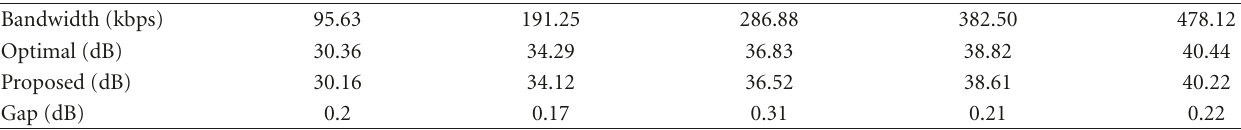
Table 1: Performance gap: low motion.